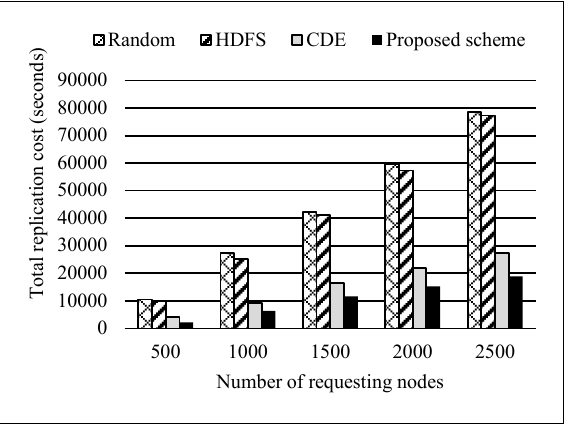
Fig. 9. The comparison of total replication